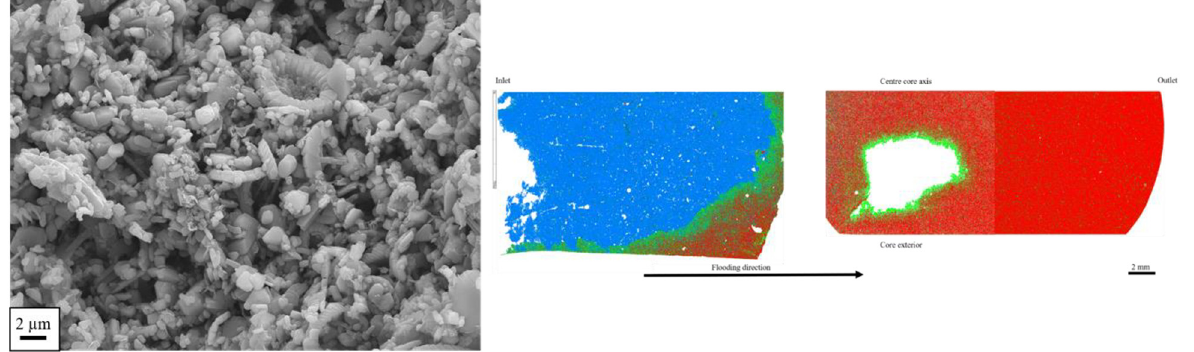
Figure 4. Comparison of scales. Grain-sizes of chalk are smaller than 1 μ m, which is more or less the spot-size limit of methods such as MLA where mapping of larger areas in centimeter sizes are pos- sible. Data and modified figure from [10].